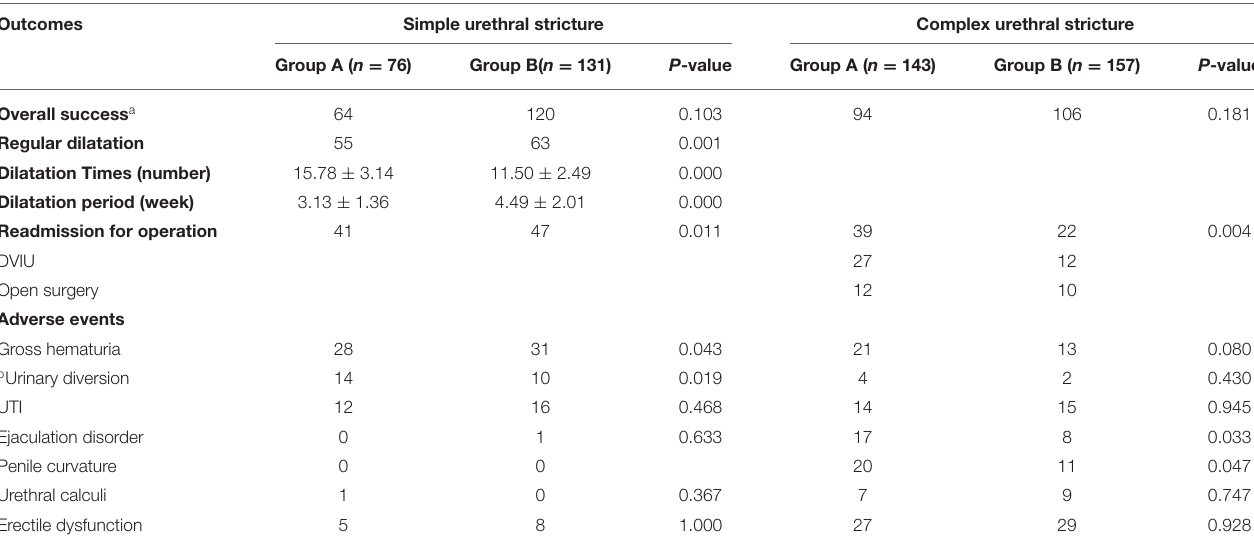
TABLE 3 | Therapeutic outcomes between the two groups.